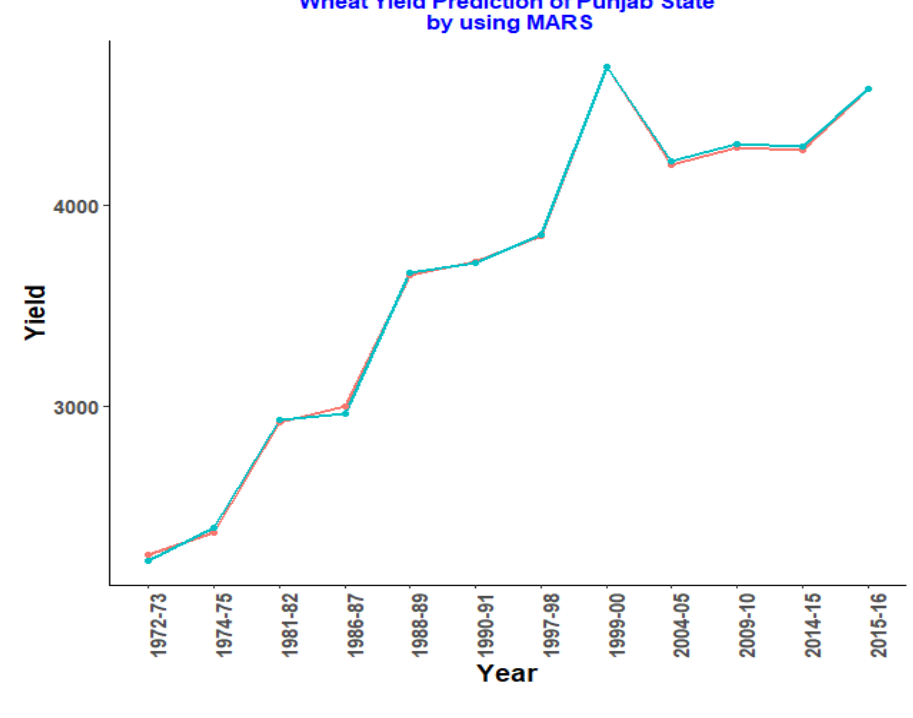
Figure 4. MARS model for Punjab.